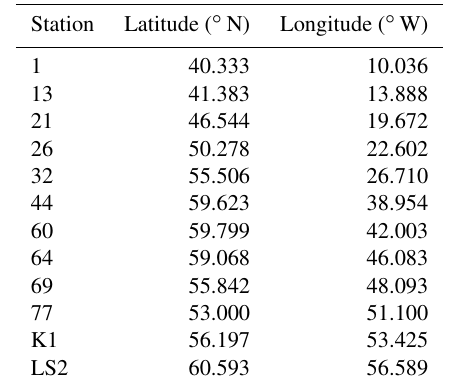
Table 1. Sampling locations from the GEOVIDE voyage in the North Atlantic Ocean and Labrador Sea (stations 1–77) and GEO- VIDE/Canada GEOTRACES intercalibration stations (stations K1 and